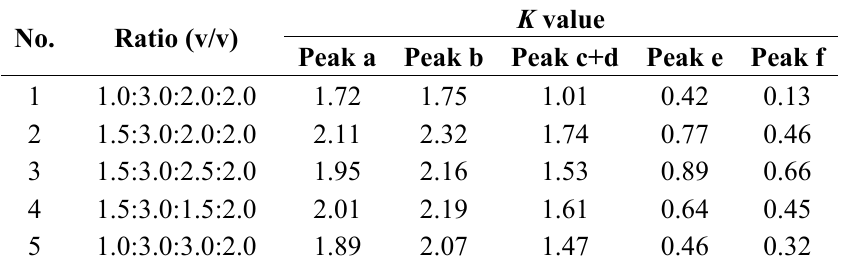
Table 1. The partition coefficients ( K values) of spirobisnaphthalenes in the two-phase solvent systems of n -hexane-chloroform-methanol-water by HPLC